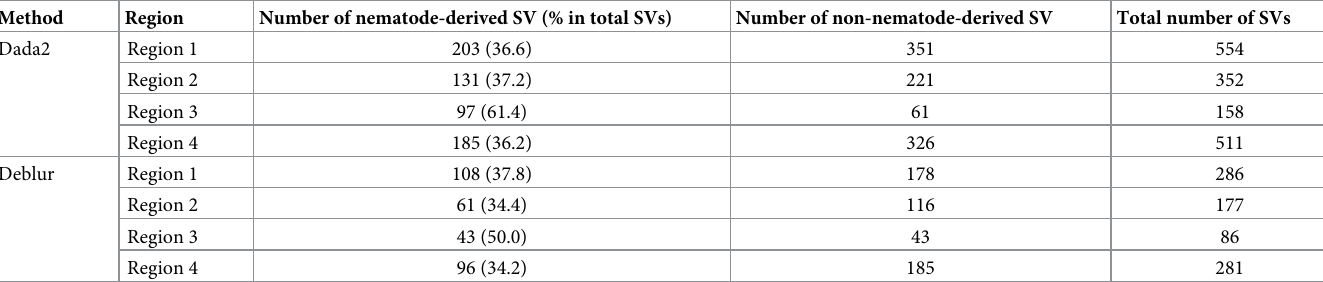
Table 2. Number of nematode- and non-nematode-derived SVs detected by dada2 and